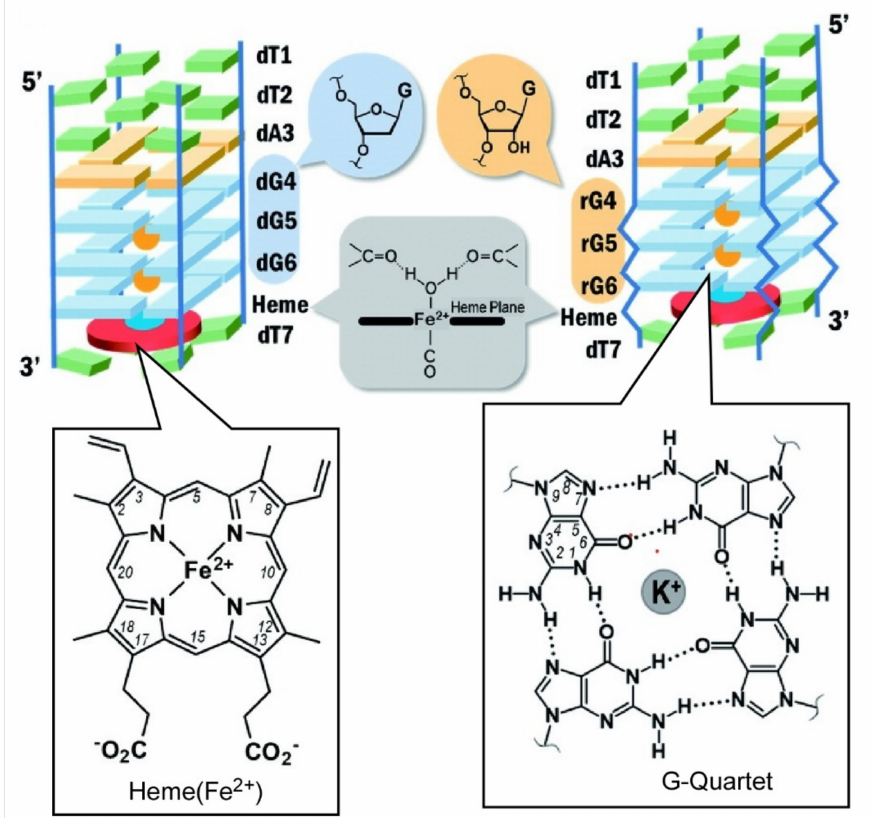
Figure 11. All-parallel tetrameric G-quadruplex consisting of a DNA/RNA chimera sequence for incorporation of heme units. Reprinted with permission from Reference [140]. Copyright 2020 Chemical Society of